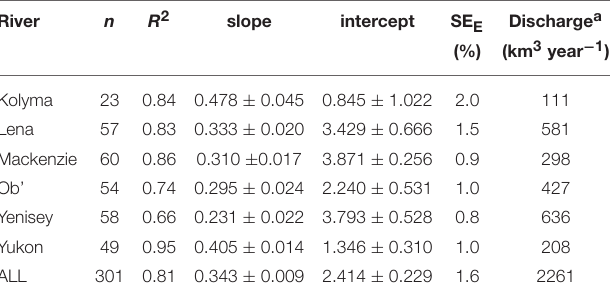
TABLE 4 | Linear regression fits for relationships between dissolved organic carbon concentration (DOC) and absorbance coefficient ( a 350 ) determined for each